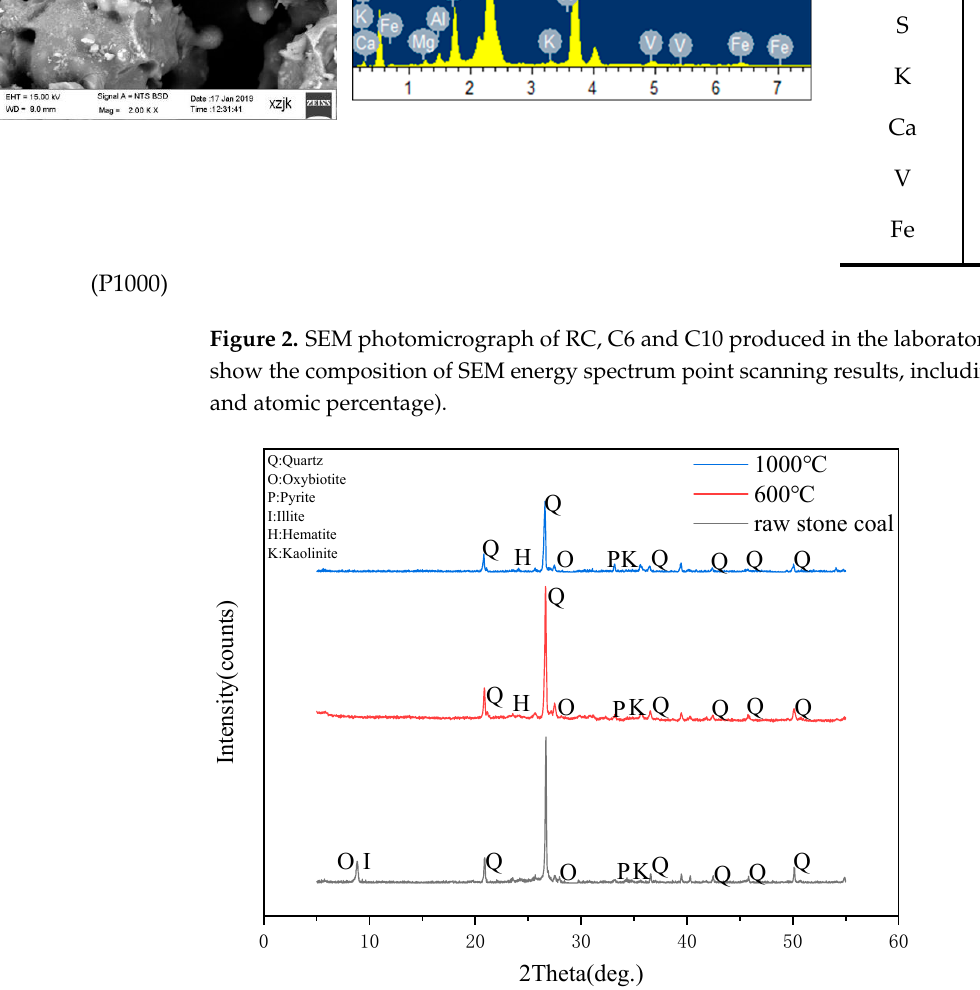
Figure 3. XRD patterns of raw stone coal, combustion residue after burning at 600 °C and 1000